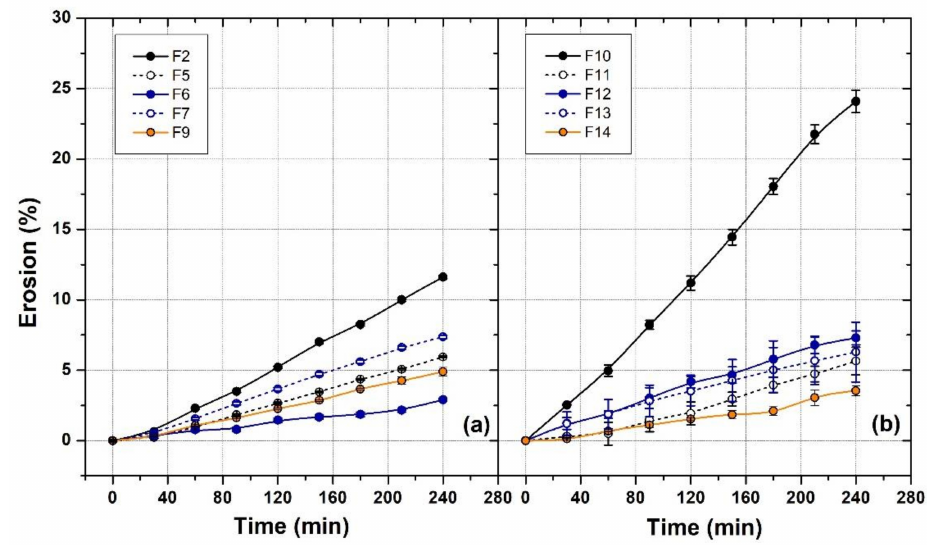
Figure 2. Erosion test with formulation prepared in water ( a ) and in PBS 1 × ( b ). The solid lines were trend curves inserted for easy viewing.